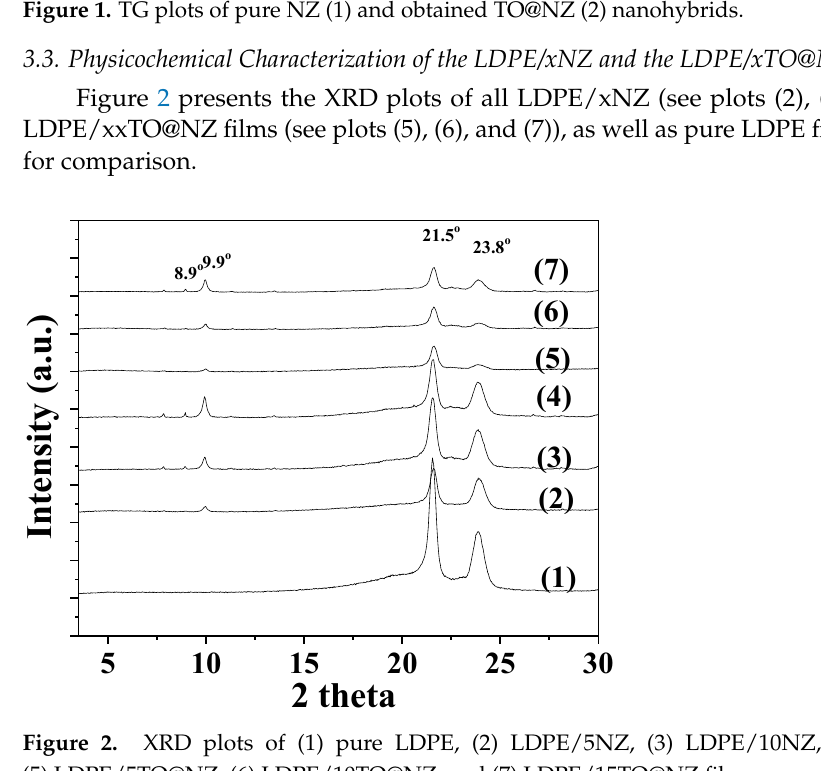
Figure 1. TG plots of pure NZ (1) and obtained TO@NZ (2) nanohybrids.